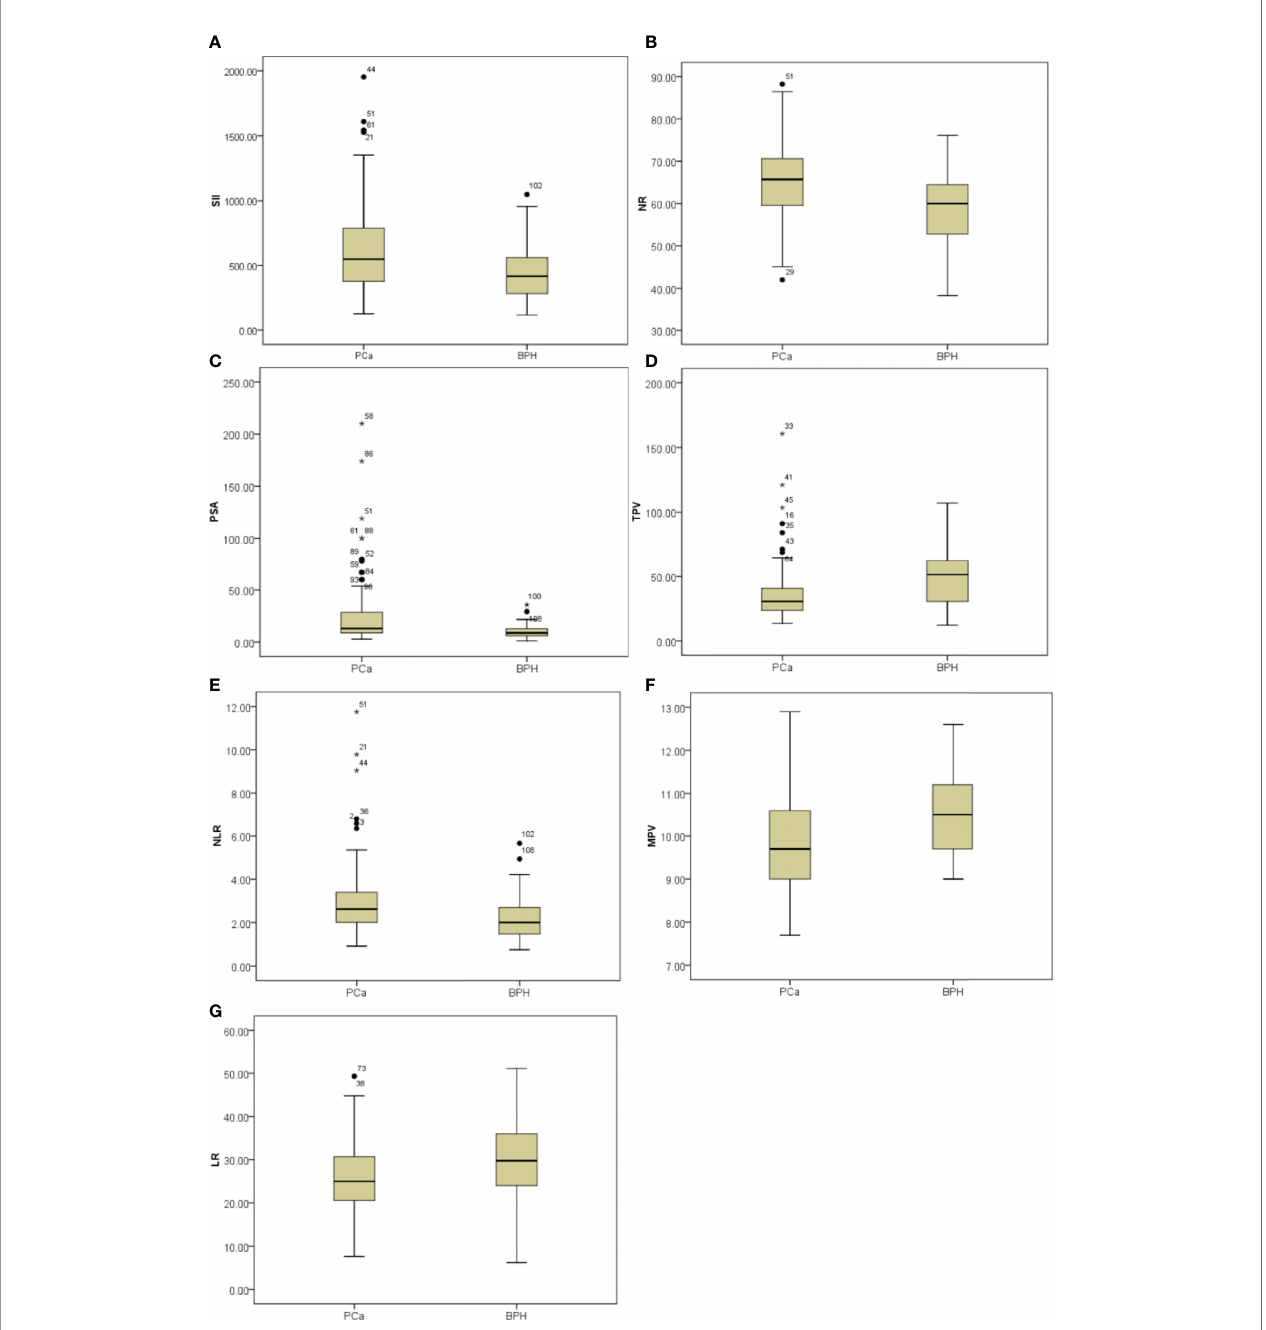
FIGURE 1 | Box-blot graphics of in fl ammatory markers including SII, NR, PSA, TPV, NLR, MPV, and LR for patients with PCa and patients with BPH. (A – C, E) SII, NR, PSA, and NLR in the PCa group were signi fi cantly higher than in the BPH group, p = 0.008, p = 0.004, p = 0.006, p = 0.034, respectively. (D, F, G) TPV, MPV, and LR in the PCa group were signi fi cantly lower than in the BPH group, p = 0.022, p = 0.003, p = 0.025,